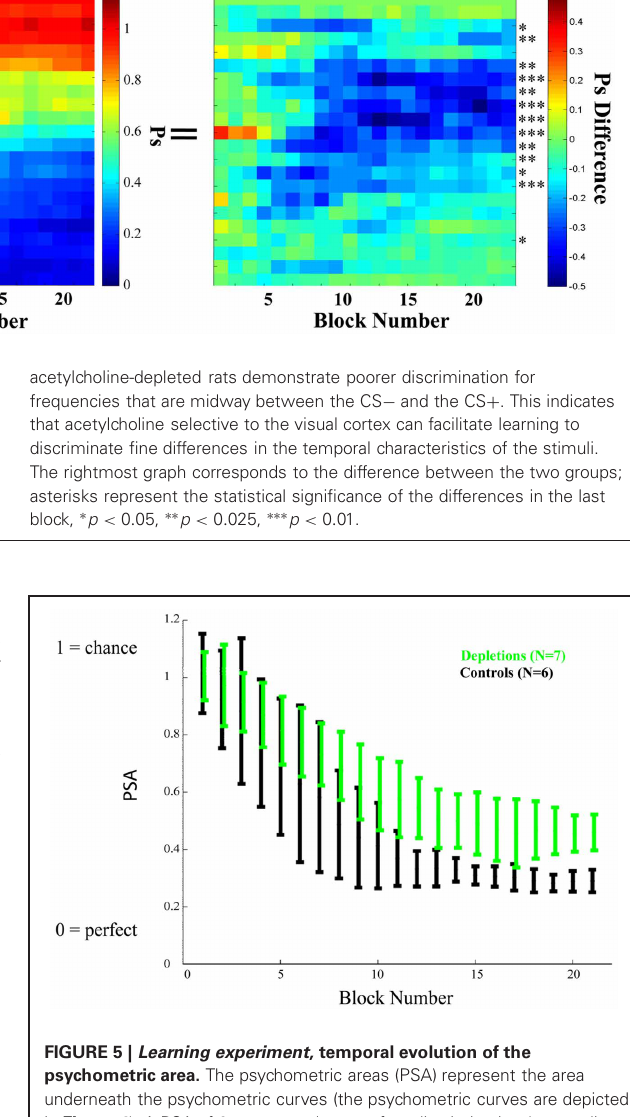
FIGURE 5 | Learning experiment , temporal evolution of the psychometric area. The psychometric areas (PSA) represent the area underneath the psychometric curves (the psychometric curves are depicted in Figure 4 ). A PSA of 0 corresponds to perfect discrimination (responding to the CS + only) and a PSA of 1 corresponds to no discrimination (responding equally to all stimuli). Acetylcholine depleted rats demonstrate a significant impairment in performance after block 12, p < 0 . 02. Error bars represent the standard